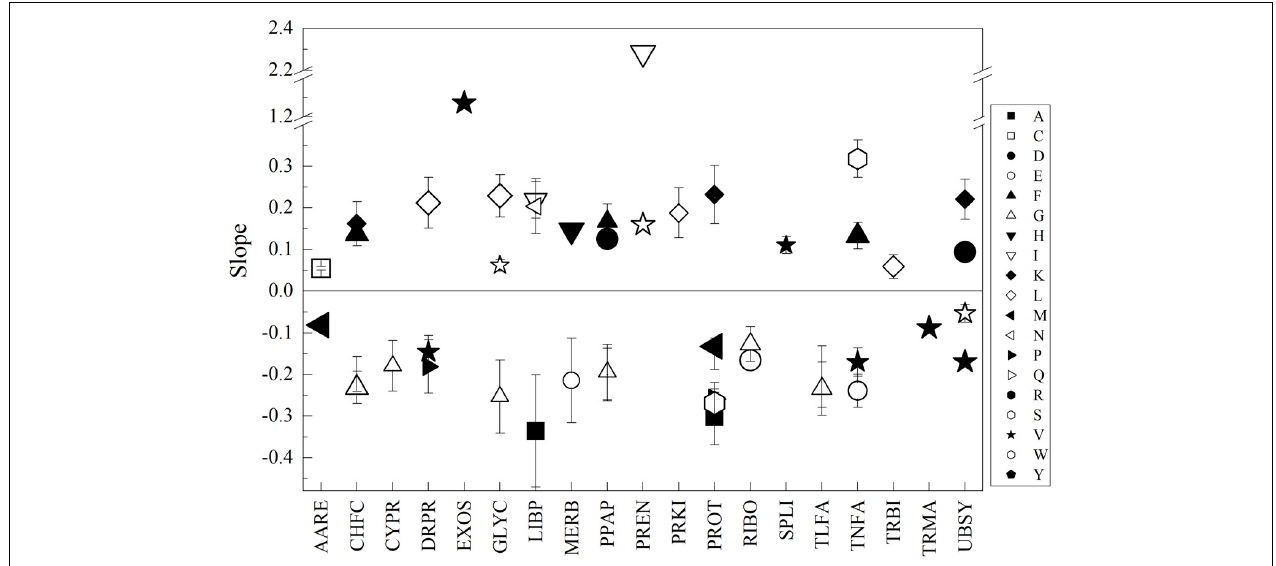
FIGURE 3 | Relationships between the content of amino acids and optimal temperature for growth among yeasts. The difference between yeasts in their amino acid content by CDS groups (indicated in the X -axis) were plotted vs. their difference in optimal temperature for growth, and linear regression was applied. The slopes from regressions with R 2 ≥ 0.7 are shown. The size of the symbol represents R 2 from 0.7 to 1.0.